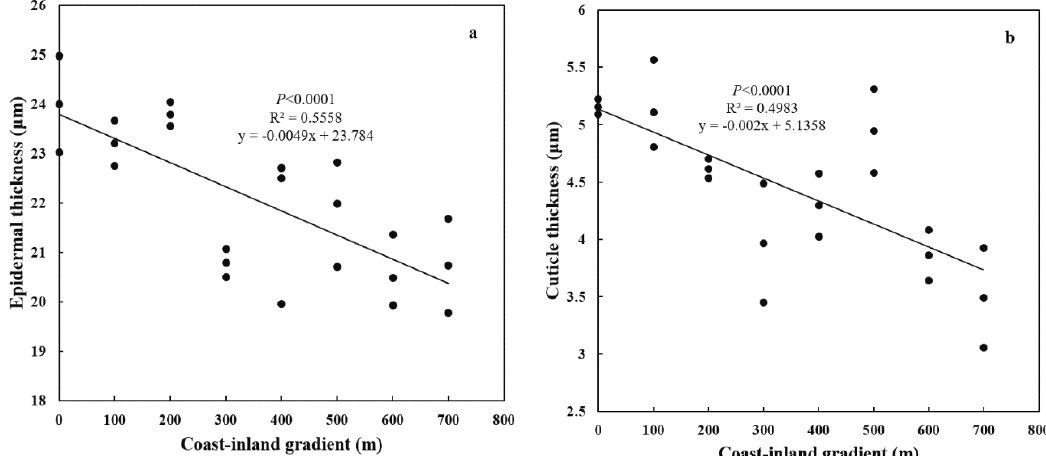
Figure 4. Variations in leaf morphology for P. thunbergii along the coast-inland gradient. ( a ) Special leaf area (SLA), and ( b ) Leaf thickness.